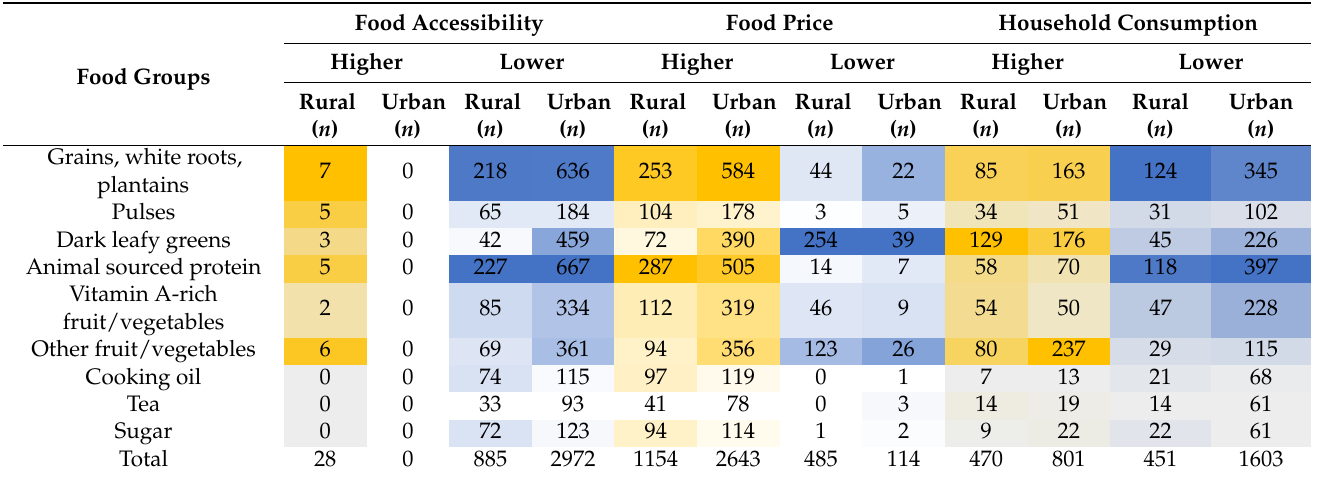
Table 3. Reported increase and decreased food accessibility, price, and consumption of select food groups in rural and urban communities in Kenya.